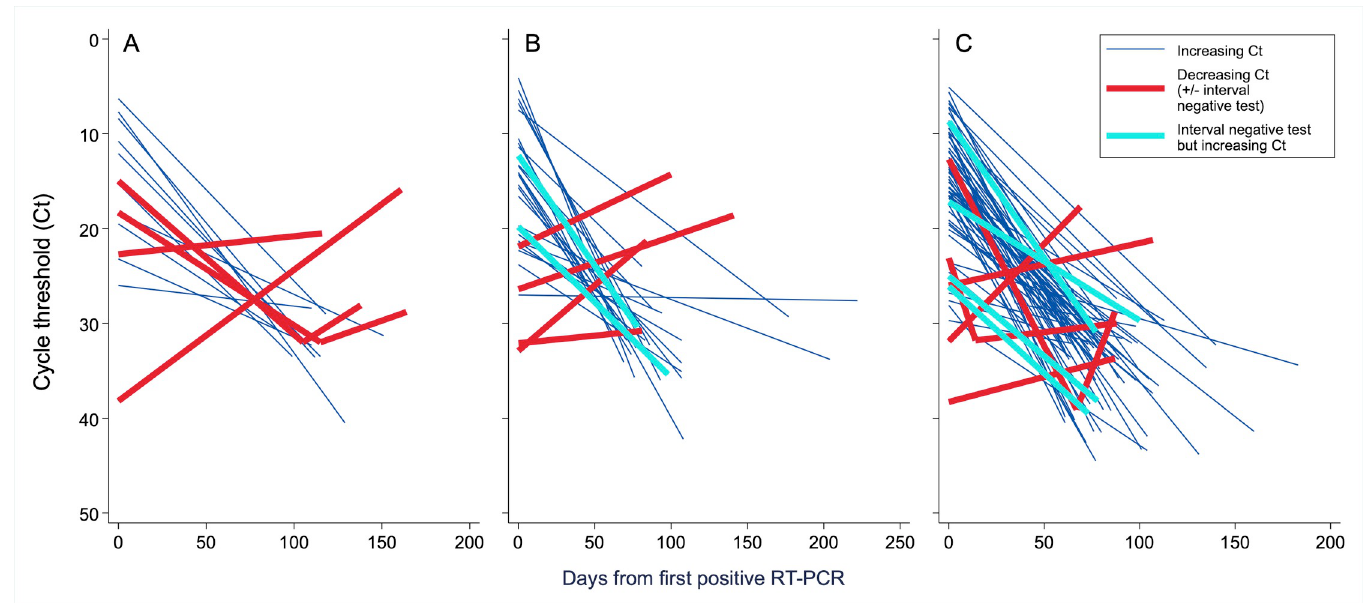
Fig 4. SARS-CoV-2 RT-PCR cycle threshold trajectory by clinical recurrence likelihood. Cycle threshold trajectory for each patient (N = 114) with a recurrent positive SARS-CoV-2 RT-PCR � 60 days after their initial positive test, stratified by (A) probable (N = 14), (B) possible (N = 30), or (C) unlikely (N = 70) clinical likelihood of COVID-19 recurrence. Abbreviations: Ct, cycle threshold; Neg, negative; RT-PCR, reverse transcription polymerase chain reaction.